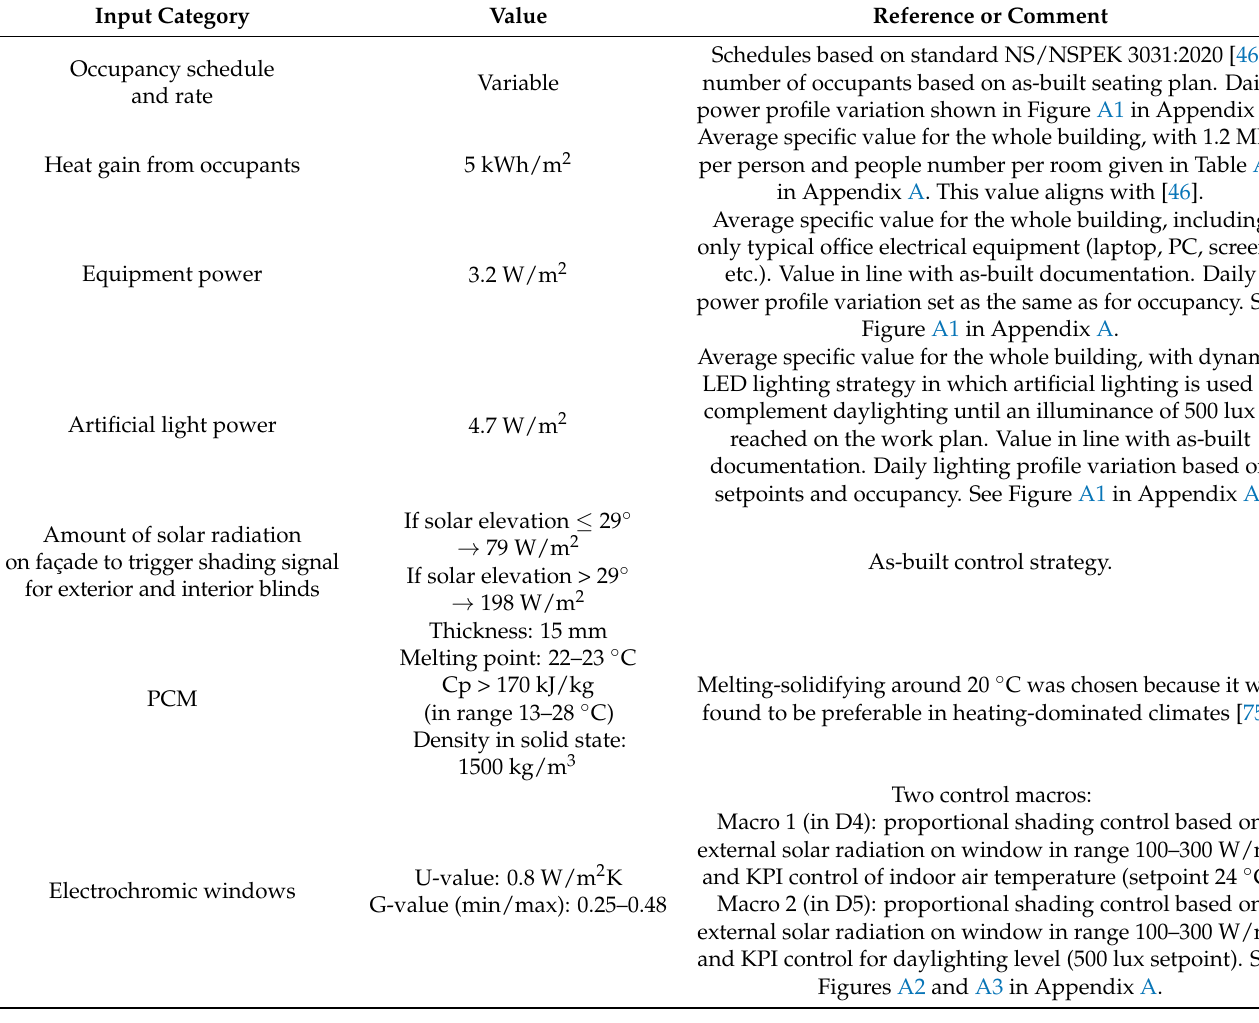
Table 4. Key parameters for the analysed